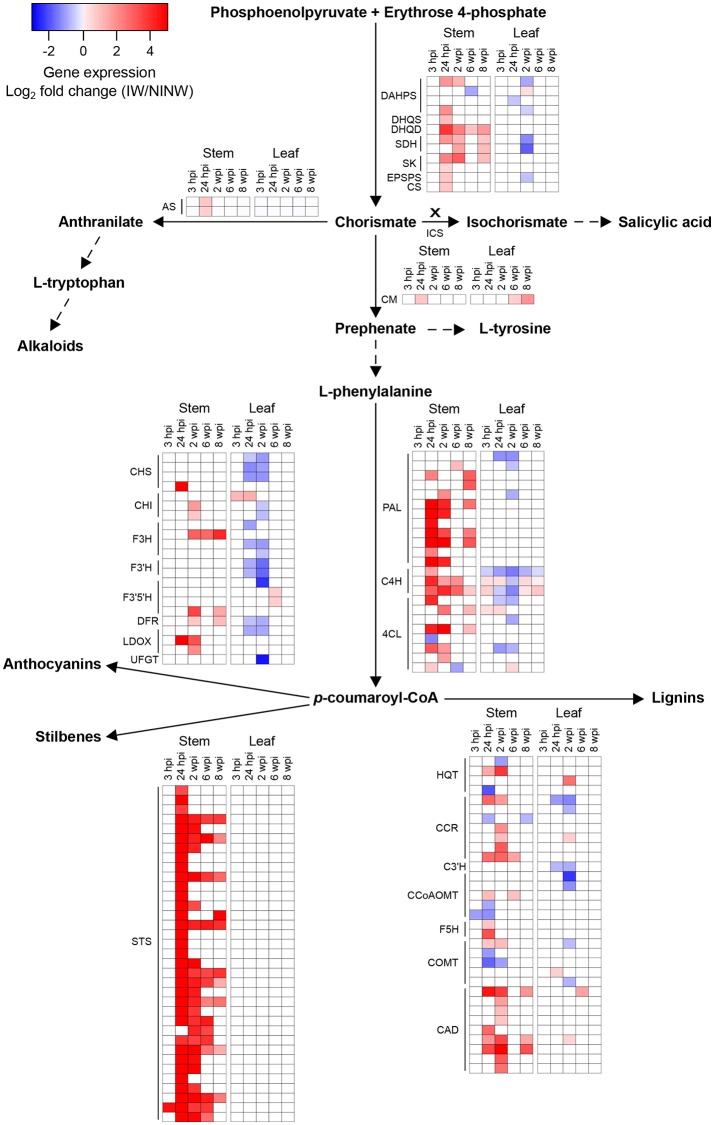
Transcriptional modulation of the secondary metabolism-associated genes in response to N. parvum infection. Representation of the shikimate, phenylalanine, central phenylpropanoid, anthocyanin, stilbene and lignin biosynthetic pathways based on Kyoto Encyclopedia of Genes and Genomes pathways (www.genome.jp/kegg/pathway.html) is provided. Dashed lines indicate that the gene expression modulation is not represented for the corresponding biosynthetic pathway. The cross above the arrow indicates that no transcriptional modulation of ICS genes has been identified. Heat maps depict significant fold changes (log2) in expression of fungal infection-responsive genes, coding for biosynthetic enzymes involved in each pathway, in stem and leaf tissues from 3 hpi until 8 wpi. Colors in the heat maps represent the intensity of the expression changes. Shikimate biosynthetic pathway: DAHPS, 3-deoxy-D-arabino-heptulosonate 7-phosphate synthase; DHQS, 3-dehydroquinate synthase; DHQD, Dehydroquinate dehydratase; SDH, Shikimate dehydrogenase; SK, Shikimate kinase; EPSPS, 5-enolpyruvylshikimate 3-phosphate synthase; CS, Chorismate synthase. Phenylalanine biosynthetic pathway: AS, Anthranilate synthase; CM, Chorismate mutase. Salicylic acid biosynthetic pathway: ICS, Isochorismate synthase. Central phenylpropanoid biosynthetic pathway: PAL, Phenylalanine ammonia-lyase; C4H, Cinnamate 4-hydroxylase; 4CL, 4-coumarate-CoA ligase. Anthocaynin biosynthetic pathway: CHS, Chalcone synthase; CHI, Chalcone isomerase; F3H, Flavonone-3-hydroxylase; F3′H, Flavonoid-3'-hydroxylase; F3′5′H, Flavonoid-3',5'-hydroxylase; DFR, Dihydroflavonol 4-reductase; LDOX, Leucoanthocyanidin dioxygenase; UFGT, UDP-glucose:flavonoid 3-O-glucosyltransferase. Stilbene biosynthetic pathway: STS, Stilbene synthase. Lignin biosynthetic pathway: HQT, Hydroxycinnamoyl-CoA quinate hydroxycinnamoyltransferase; CCR, Cinnamoyl-CoA reductase; C3′H, P-coumaroyl 3'-hydroxylase; CCoAOMT, Caffeoyl-CoA O-methyltransferase; F5H, Ferulate 5-hydroxylase, COMT, Caffeic acid O-methyltransferase; CAD, Cinnamyl alcohol dehydrogenase.